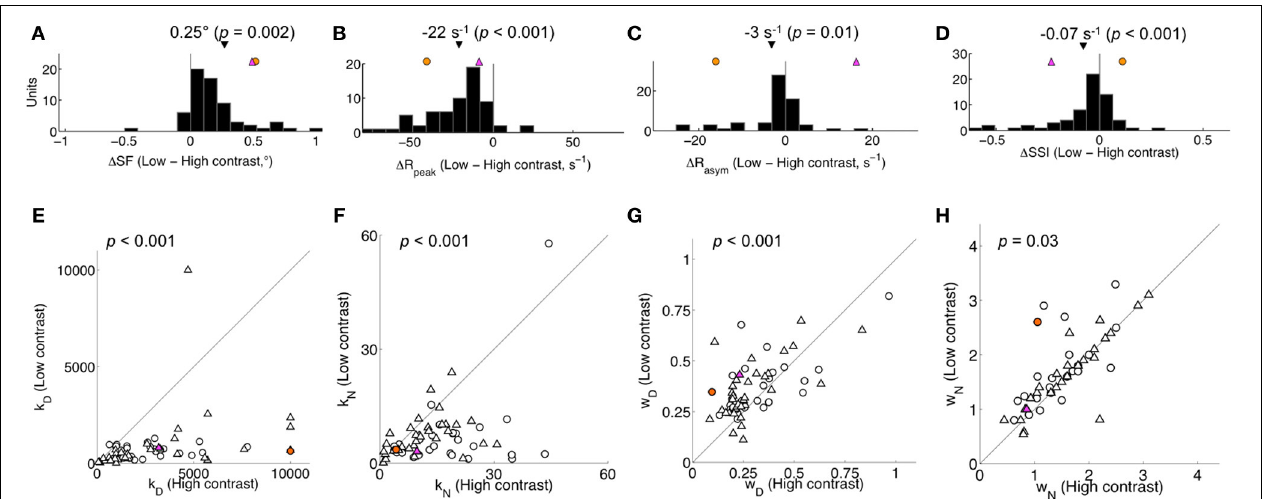
FIGURE 5 | Population effect of stimulus contrast on area summation during the control condition. (A–D) Summation curve features: difference in summation field (SF), peak response rate ( R peak ), asymptote response rate ( R asym ), and surround suppression index (SSI) between high and low contrast stimuli. Black triangle indicates population mean (with two-tailed t -test p -value). (E–H) Parameter estimates ( k D , k N , w D , w N ) for all units plotted for high contrast vs. low contrast conditions. p -values correspond to a two-tailed Mann-Whitney U -test for k D and k N , and a t -test for w D and w N . Triangles